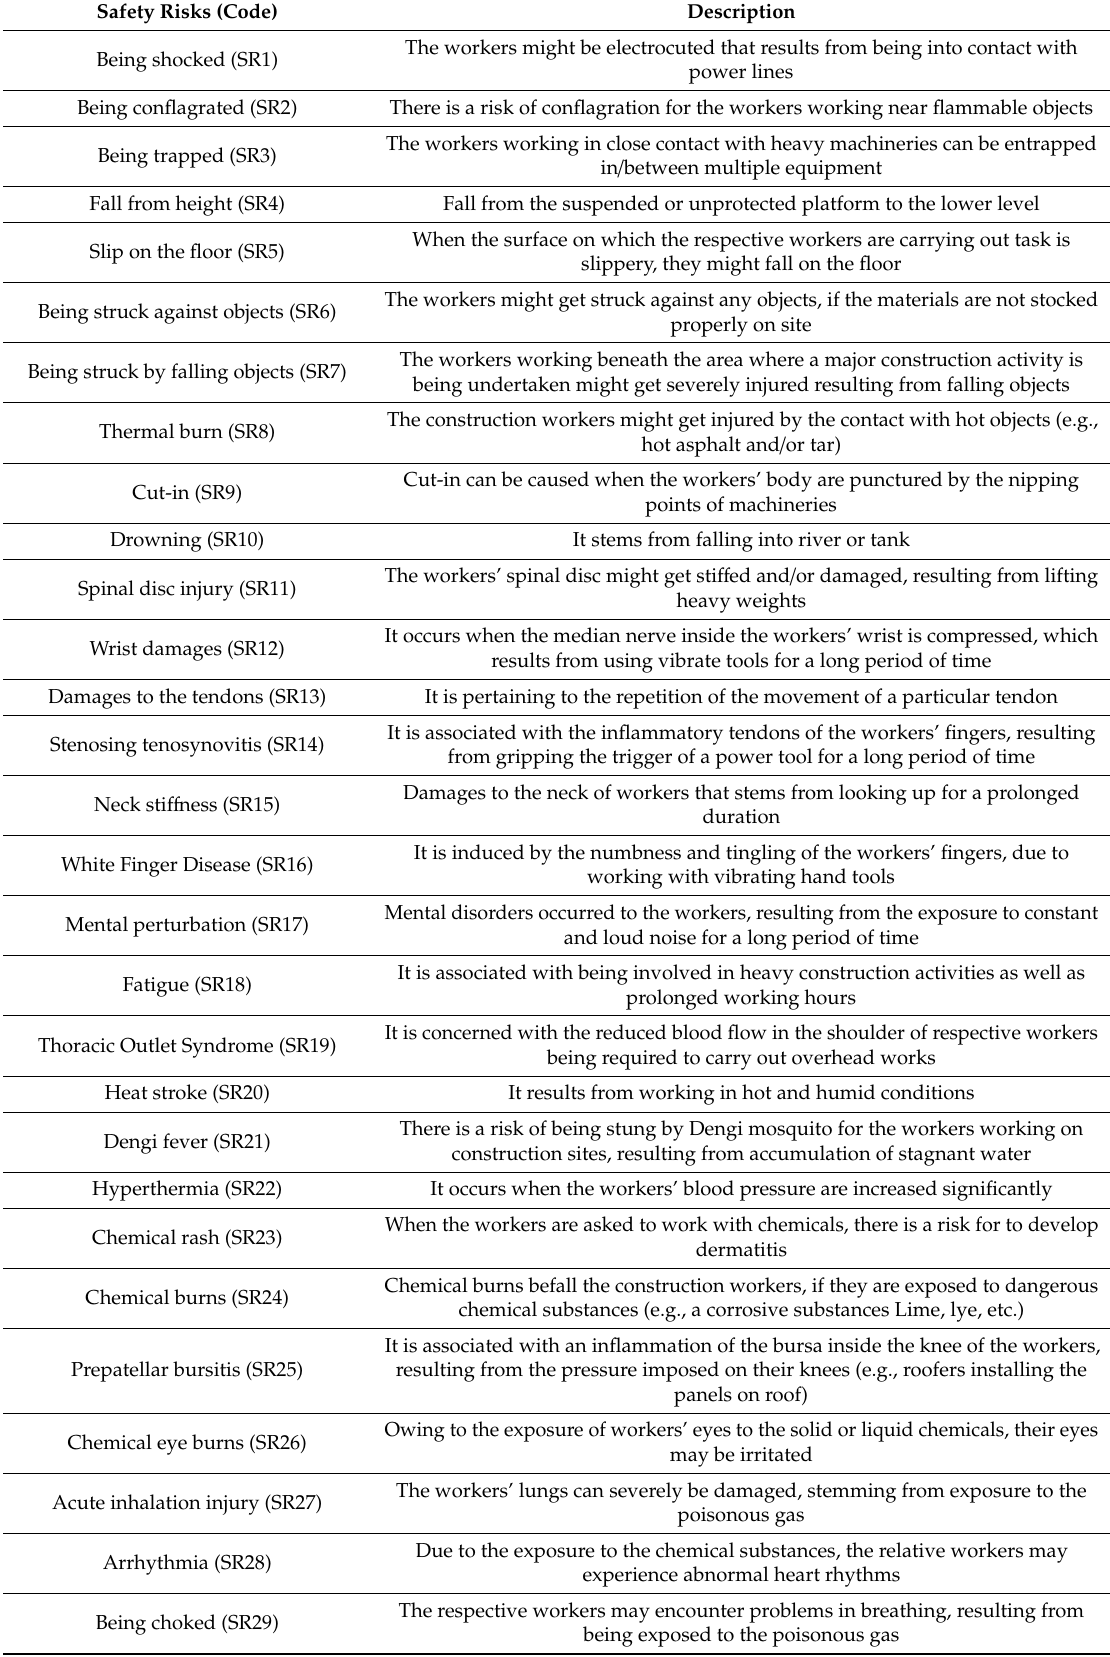
Table 7. The crucial safety risks along with their